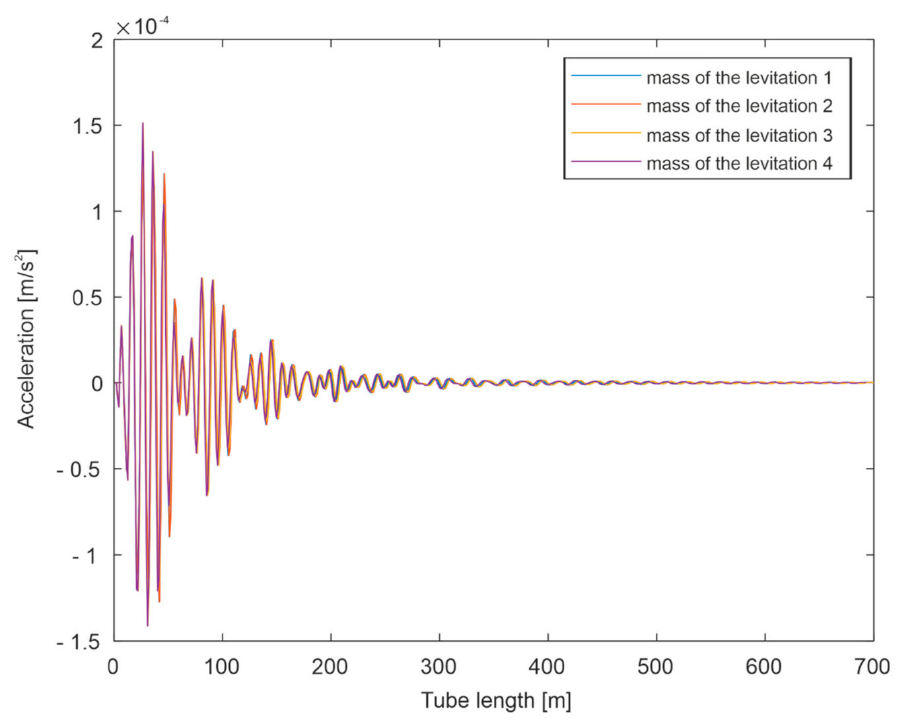
Figure 23. Acceleration on the levitation system in the direction z for 2000 km /